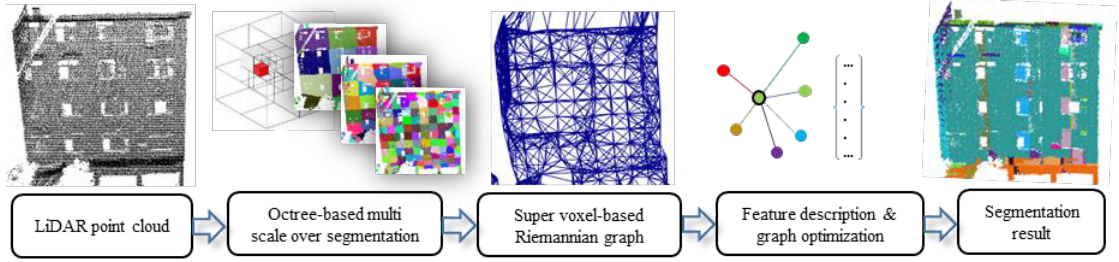
Figure 1. The schematic of the proposed